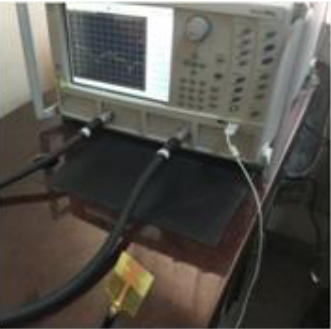
Figure 15. A photo showing the fabricated antenna input reflection coefficient measurement setup